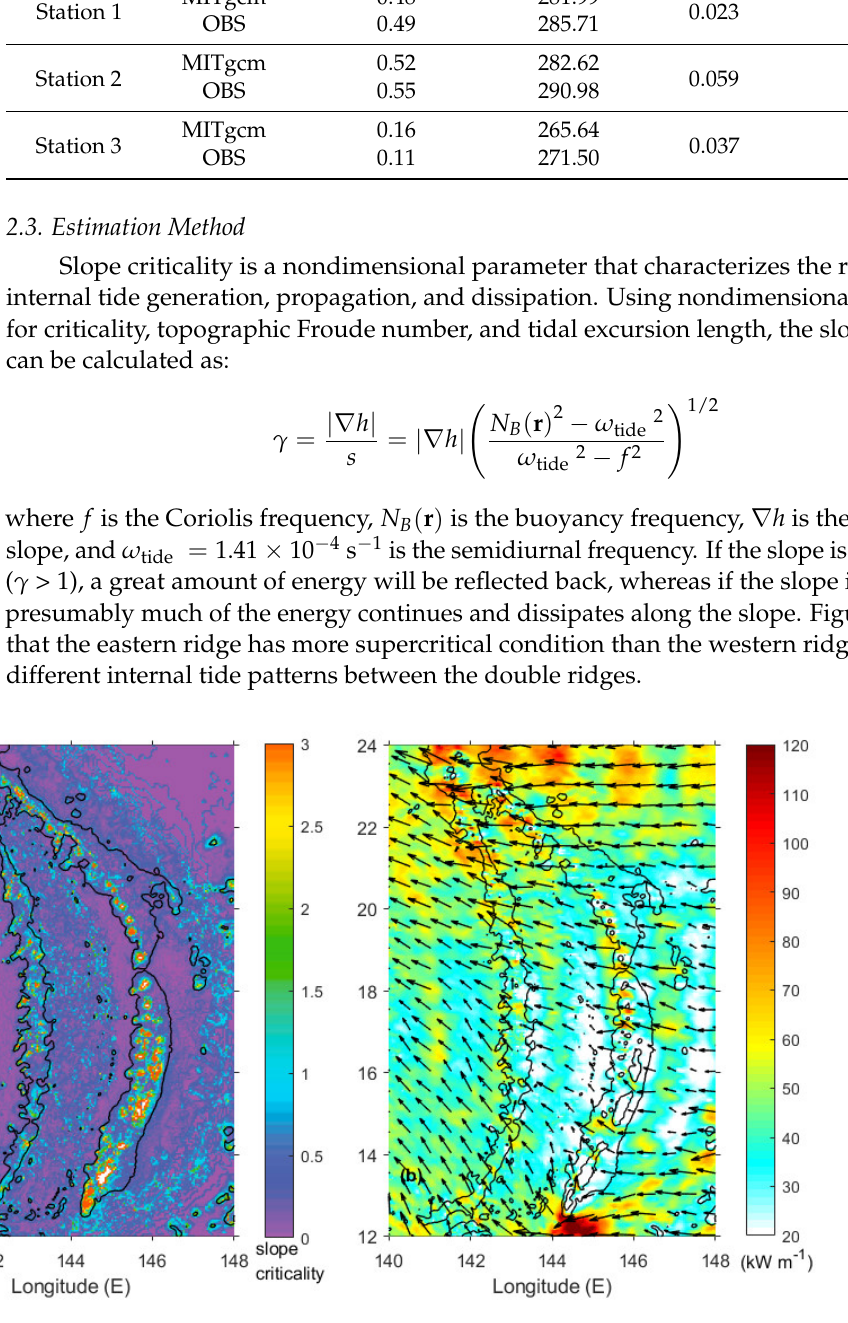
Figure 3. Slope criticality of the Mariana double ridges ( a ). Barotropic tidal energy flux (vector) and its magnitude (color shading) (kW m –1 ) ( b ). The background contours represent the 3000-m isobaths.